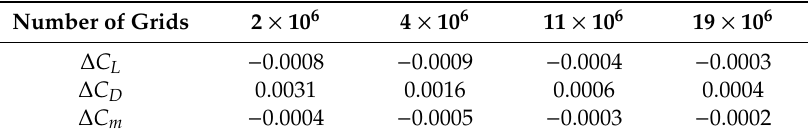
Table 1. Results of grid independence study.